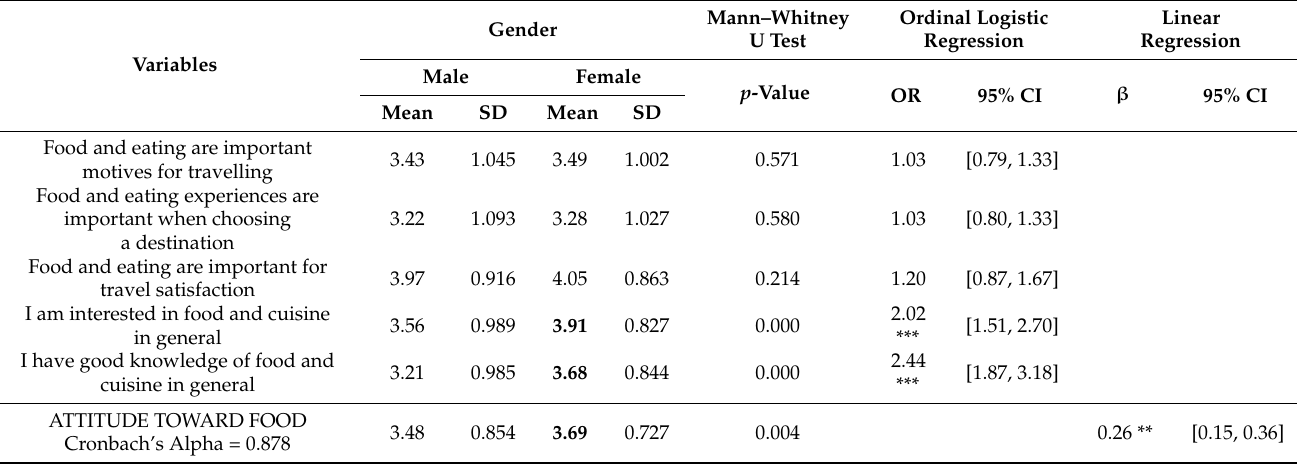
Table 5. Men and women’s attitudes toward